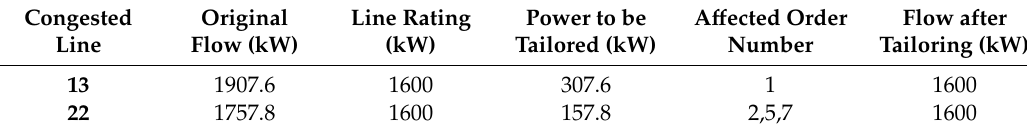
Table 4. Congested lines and tailored orders in the 30-bus test system.